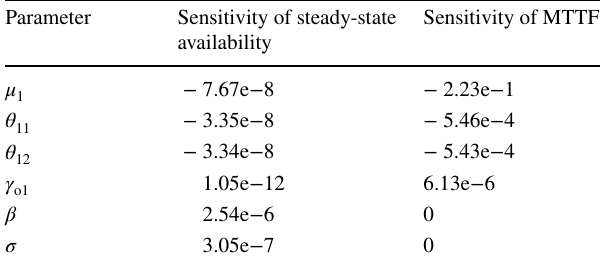
Table 4 Sensitivity of availability and